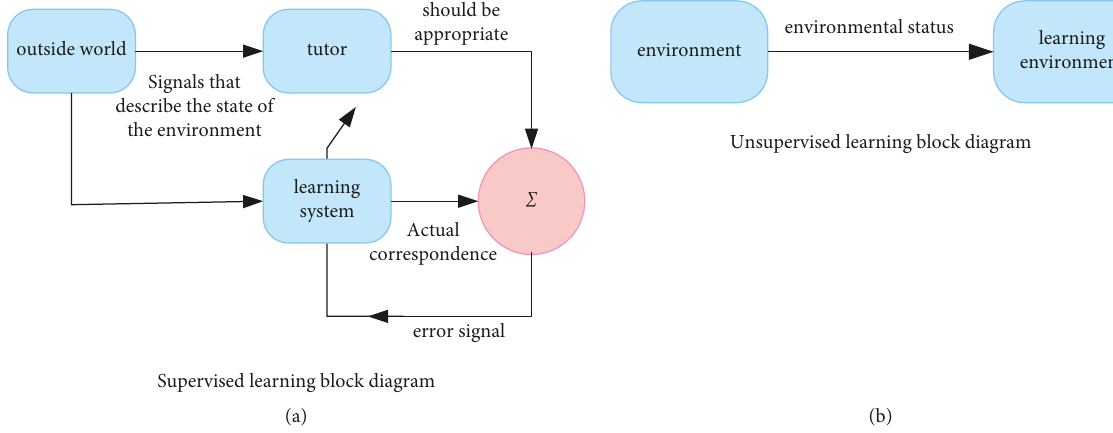
Figure 3: Learning style: (a) supervised learning block diagram and (b) unsupervised learning block diagram.